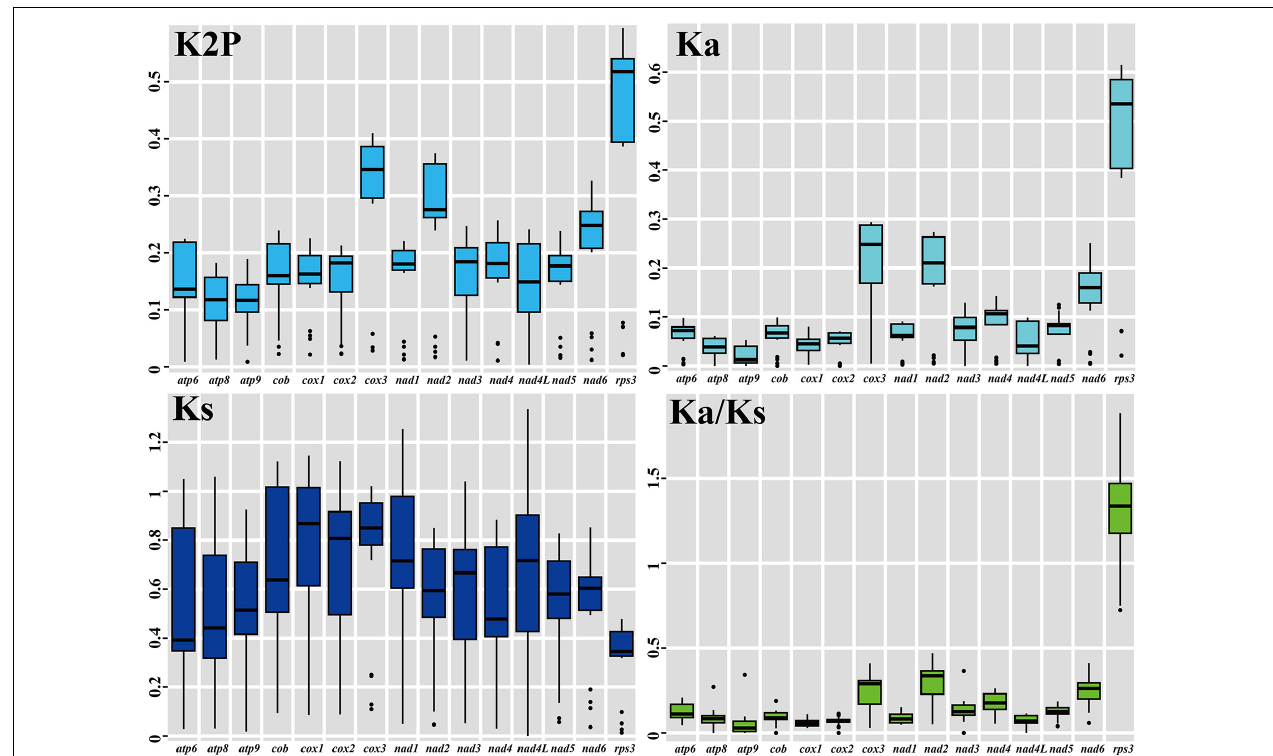
FIGURE 5 | Genetic analysis of 15 core protein coding genes conserved in the 8 Boletales mitogenomes. K2P, pairwise genetic distances between each pair of the 15 core PCGs in the 8 Boletales mitogenomes based on the Kimura-2-parameter model. Ka , non-synonymous substitution site; Ks , synonymous substitution site. Species and NCBI accession number used for genetic analysis in the present study are listed in Supplementary Table 6